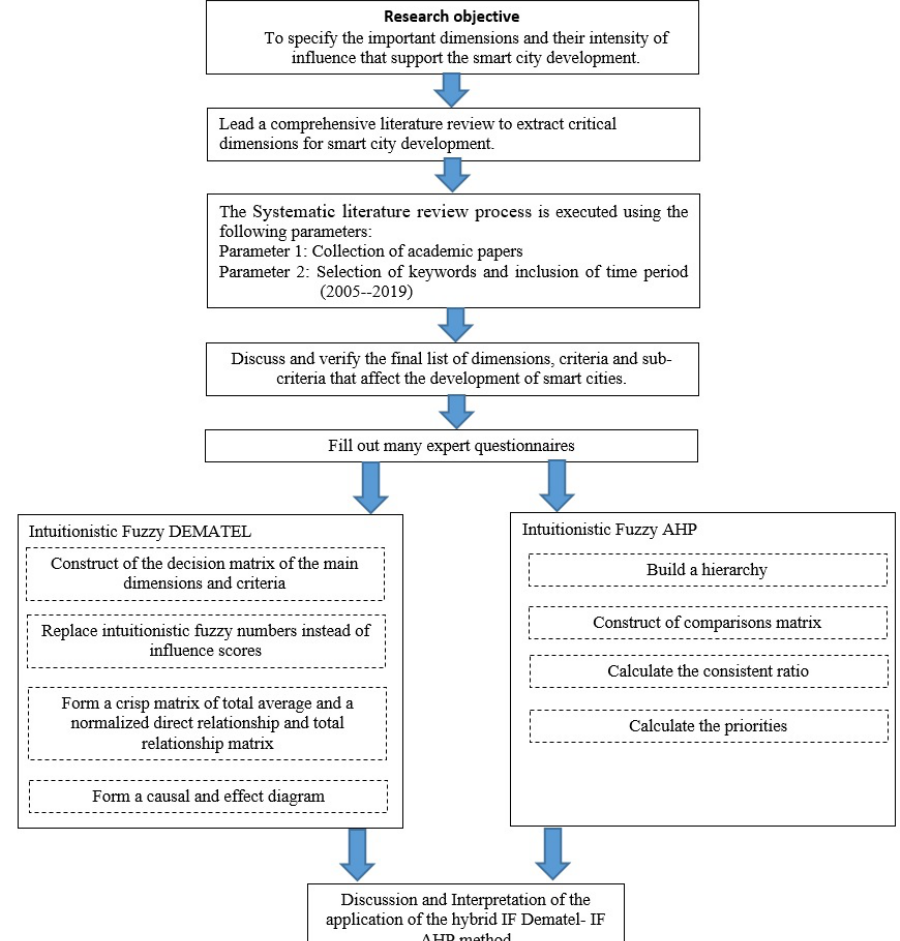
Figure 1. Architecture of the proposed